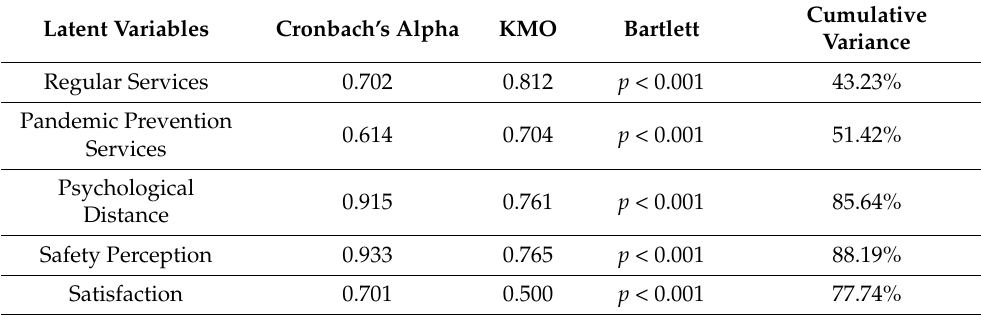
Table 2. Reliability and validity test.